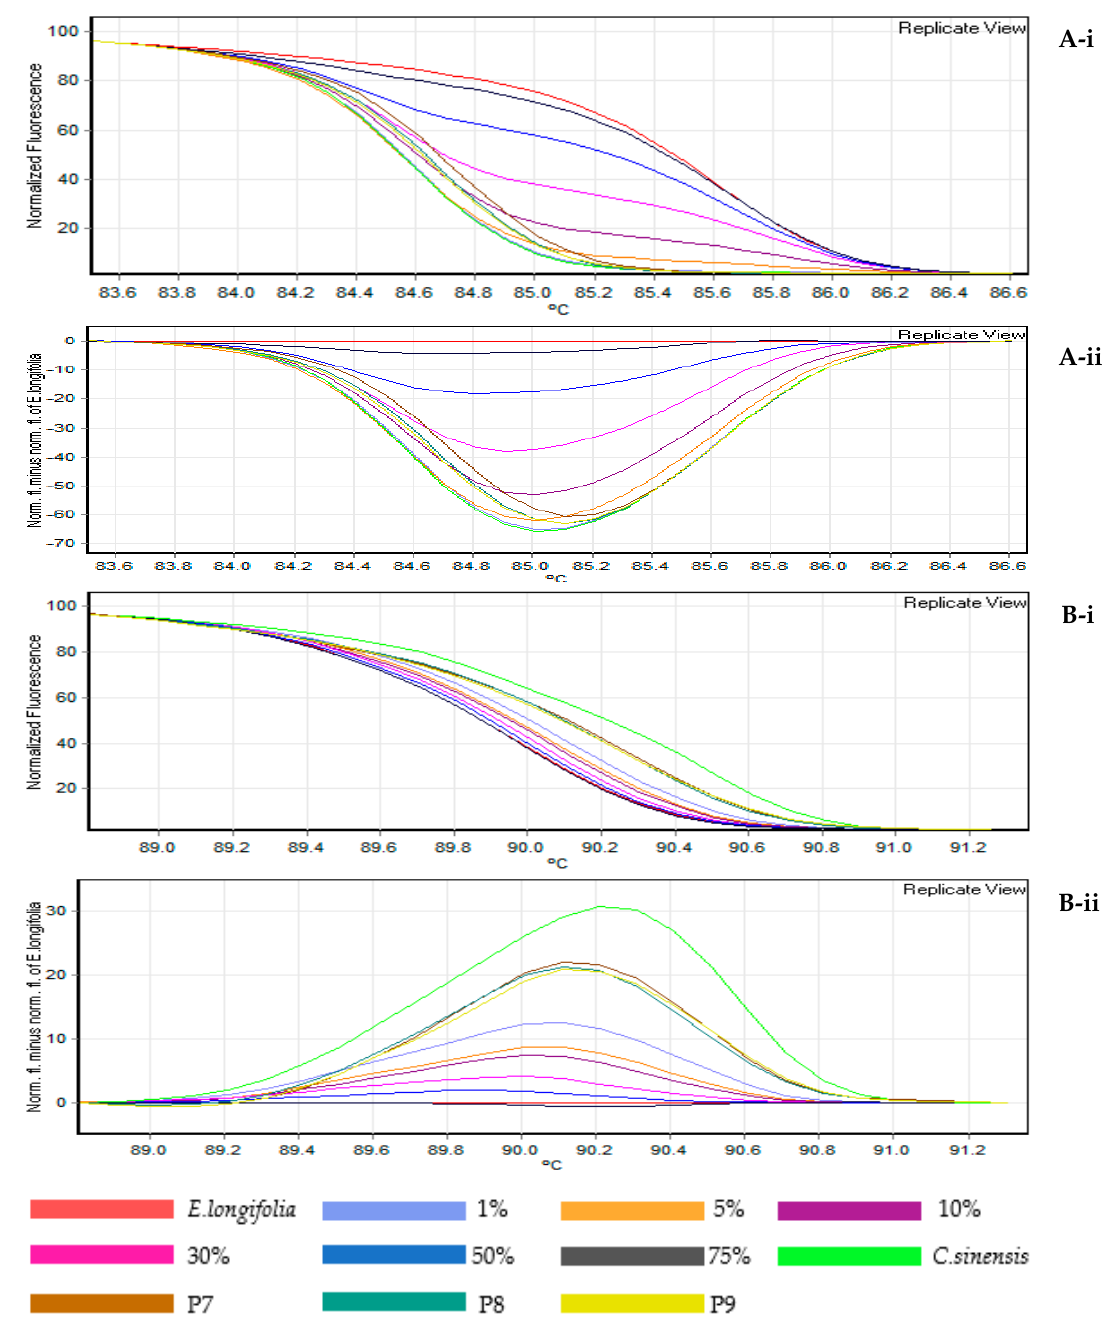
Figure 5. Adulteration of E. longifolia mixed in C. sinensis to test the sensitivity of HRM analysis in the admixture product. The mixture contained 1%, 5%, 10%, 30%, 50% and 75% E. longifolia in C. sinensis . HRM analysis targeting rbcL: ( A-i ) normalised rbcL curves, ( A-ii ) rbcL difference curves; and ITS2: ( B-i ) normalised ITS2 curves, ( B-ii ) ITS2 difference curves with E. longifolia as a reference, C. sinensis and three successfully amplified commercial admixture herbal products: P7, P8 and P9.